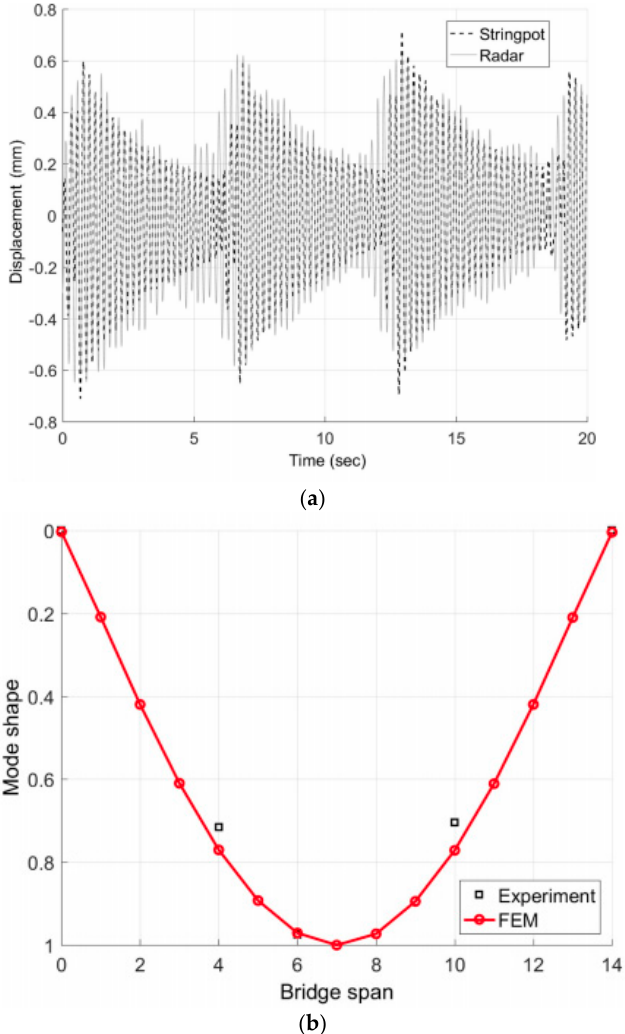
Figure 5. Experimental results for the Doppler radar sensor network operating in the active mode: ( a ) displacement measured at the midspan; ( b ) shape of the first mode. Reprinted with permission from ref. [69]. Copyright 2018 American Society of Civil Engineers .